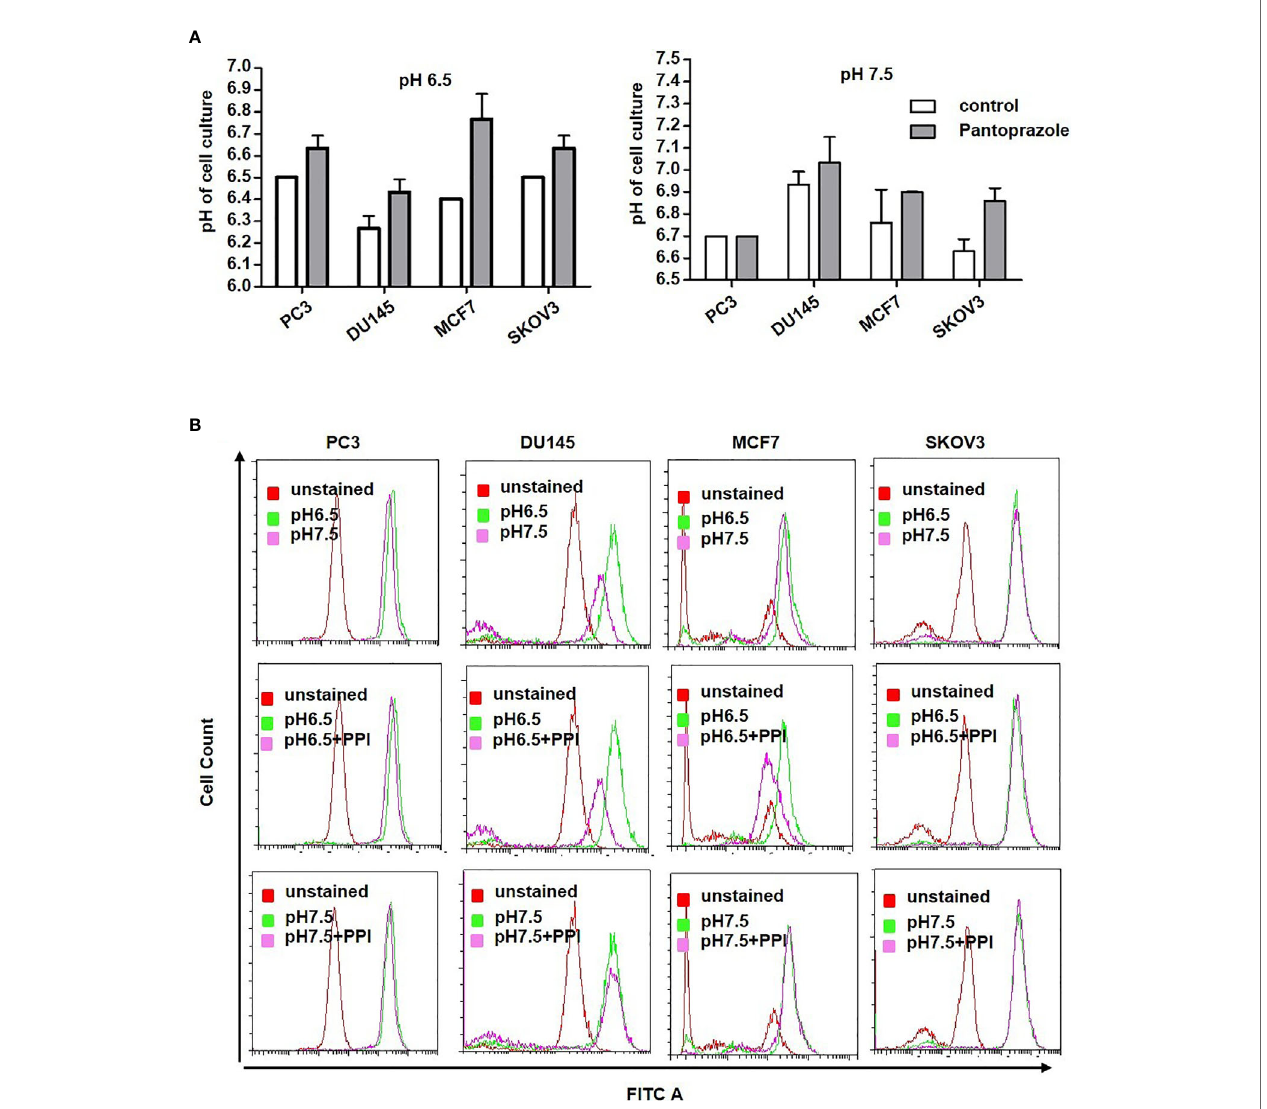
FIGURE 3 | Pantoprazole regulates the extra- and intracellular pH of cancer cells. (A) Change in the extracellular pH of the cell culture medium of prostate (PC3, DU145), breast (MCF7) and ovarian cancer (SKOV3) cells following treatment with pantoprazole (grey columns) or without pantoprazole (controls, white columns) at a pH of 6.5 or 7.5. (B) Change in the intracellular pH of prostate (PC3 and DU145), breast (MCF7) and ovarian cancer (SKOV3) cells following treatment with or without 100 m M pantoprazole for 6 h at a pH of 6.5 or 7.5. Top panel: cells were incubated in cell culture medium of different pHs; middle panel: cells were incubated in cell culture medium with a pH of 6.5 with or without pantoprazole; bottom panel: cells were incubated in cell culture medium with a pH 7.5 with or without pantoprazole. Red pick: unstained cells; pink pick: cells incubated in cell culture medium with a pH of 7.5 containing pantoprazole; green pick: cells incubated in cell culture medium with a pH of 7.5 without pantoprazole; X-axis: FITC; Y-axis: cell count. The bars represent the mean and SD of the mean of n ≥